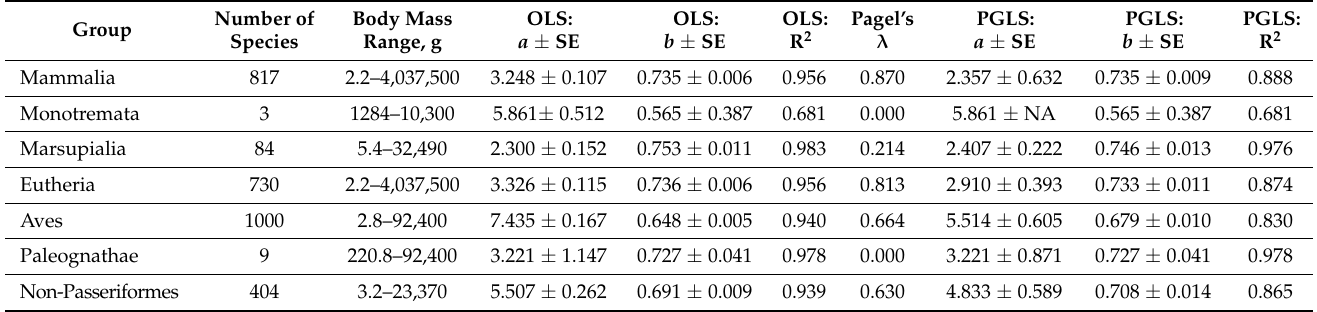
Figure 2. BMR as function of body mass in major groups of endotherms. Table 1. Parameters of allometric equation for basal metabolic rate in main groups of endothermic animals.